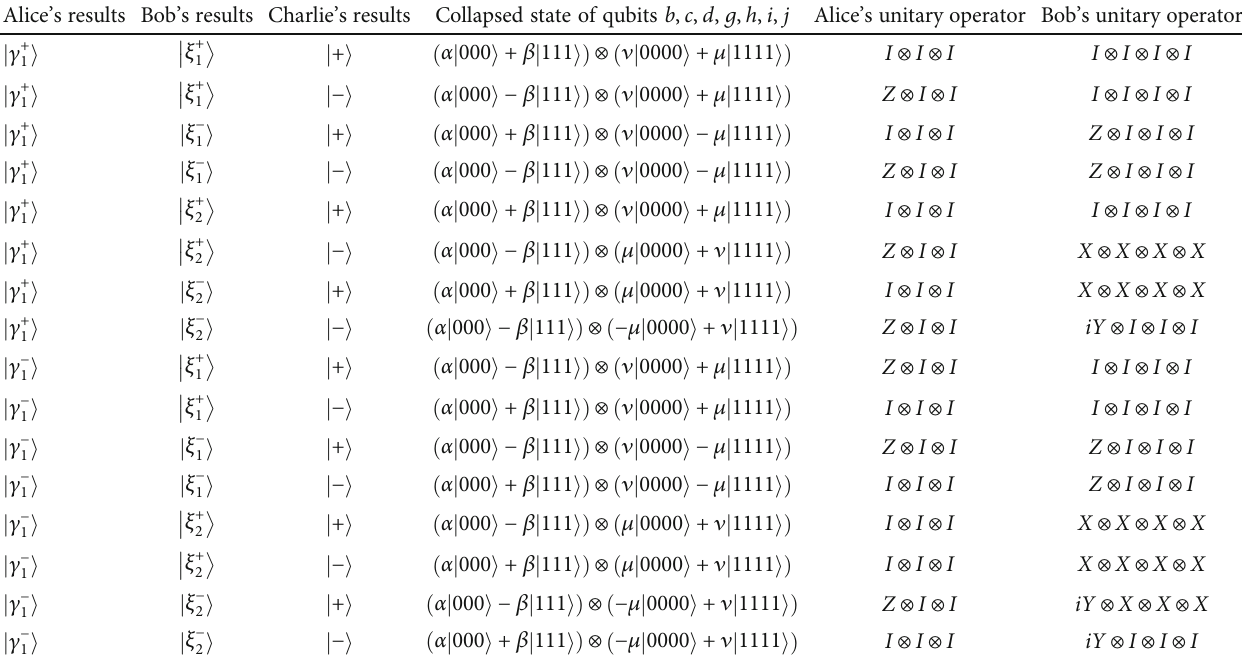
Table 2: The speci fi c unitary transformation and collapsed states correspond to Alice ’ s, Bob ’ s, and Charlie ’ s measurement results. Alice ’ s results Bob ’ s results Charlie ’ s results Collapsed state of qubits b , c , d , g , h , i , j Alice ’ s unitary operator Bob ’ s unitary